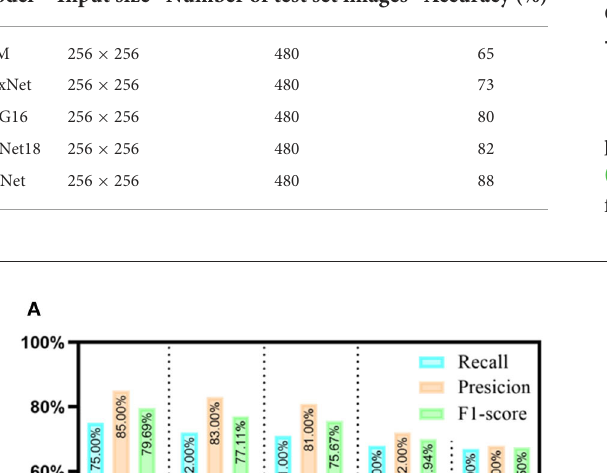
TABLE 3 Test accuracy of disease spots and insect spots images in different network models.